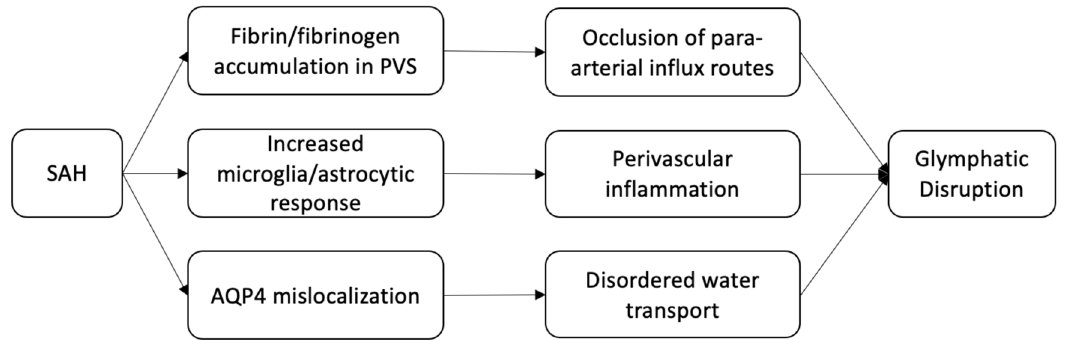
Figure 2. Mechanisms driving glymphatic disruption following SAH Drugs targeting the